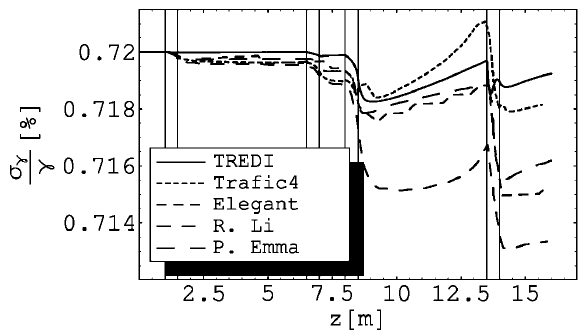
FIG. 16. Relative beam energy spread versus average bunch longitudinal coordinate along the beam line. All results ob- tained with codes other than TREDI are from the ICFA Zeuthen Workshop web site [19]. Results obtained with the different codes were shifted to make the initial values to equal the nominal relative energy spread required for the Workshop benchmark